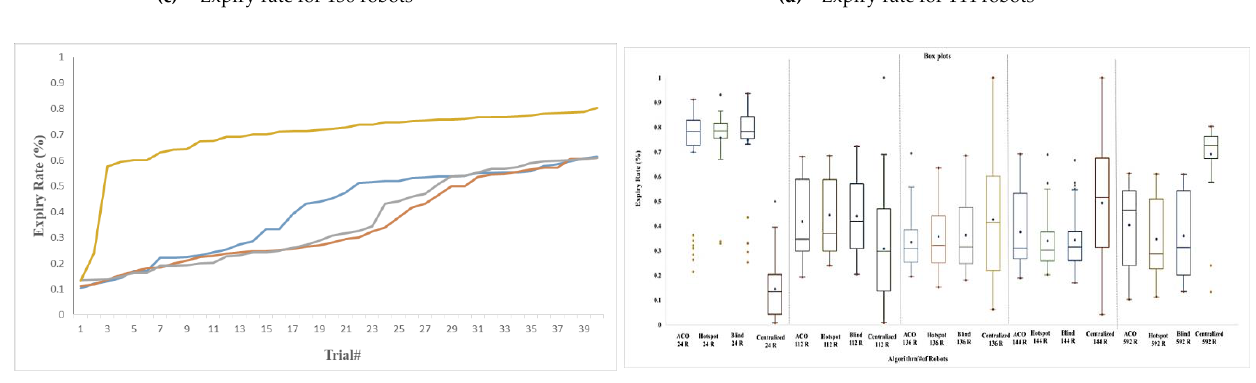
Figure 9. Scalability results for 40 trials with different setups. The results are ordered from smallest to largest for better representation ( a – f ).